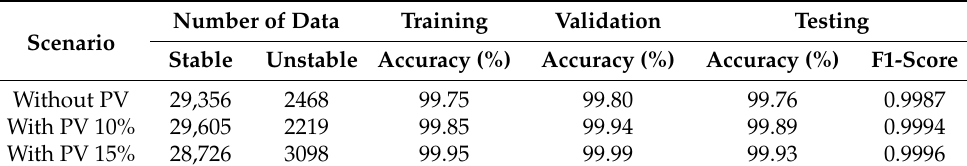
Table 3. Generation data of PV penetration effect representation.